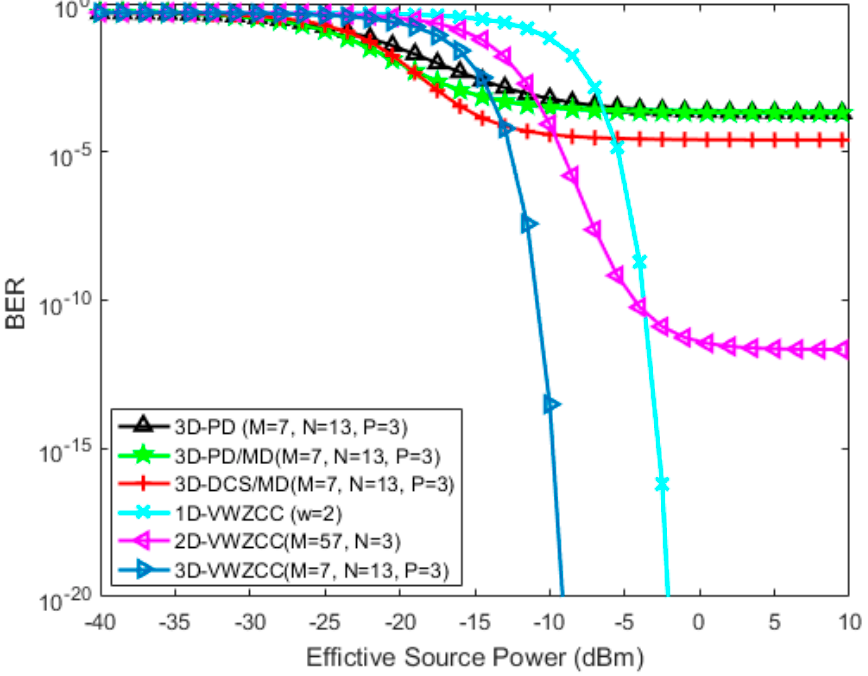
Figure 6. BER against effective source power when the number of simultaneous users K = 150 and data rate R (cid:2912) = 1.25 Gbps.